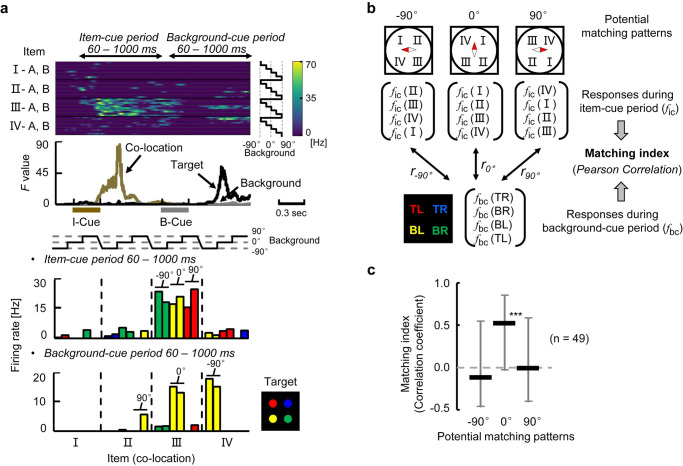
Representation of retrieved location and target location.(a) Example neuron signaling a particular co-location during the item-cue period and a particular “targeting” location during the B-Cue period. Same format as Fig 4A, except that target locations in the bar graph are indicated by colors (bottom panel). For example, yellow color corresponds to the bottom-left of the target location on the display. (b) Potential matching patterns between the co-location and target location. (c) Median value of matching index for each matching pattern (using neurons signaling both co-location-selectivity during the item-cue period and target-selectivity during the background-cue period, n = 49). Error bar, quarter value. ***P < 0.0001, Wilcoxon signed-rank test, 2-tailed. Source data are available in S1 Data. B-Cue, background cue; BL, bottom left; BR, bottom right; I-IV, co-location I-IV; I-Cue, item cue; TL, top left; TR, top right.